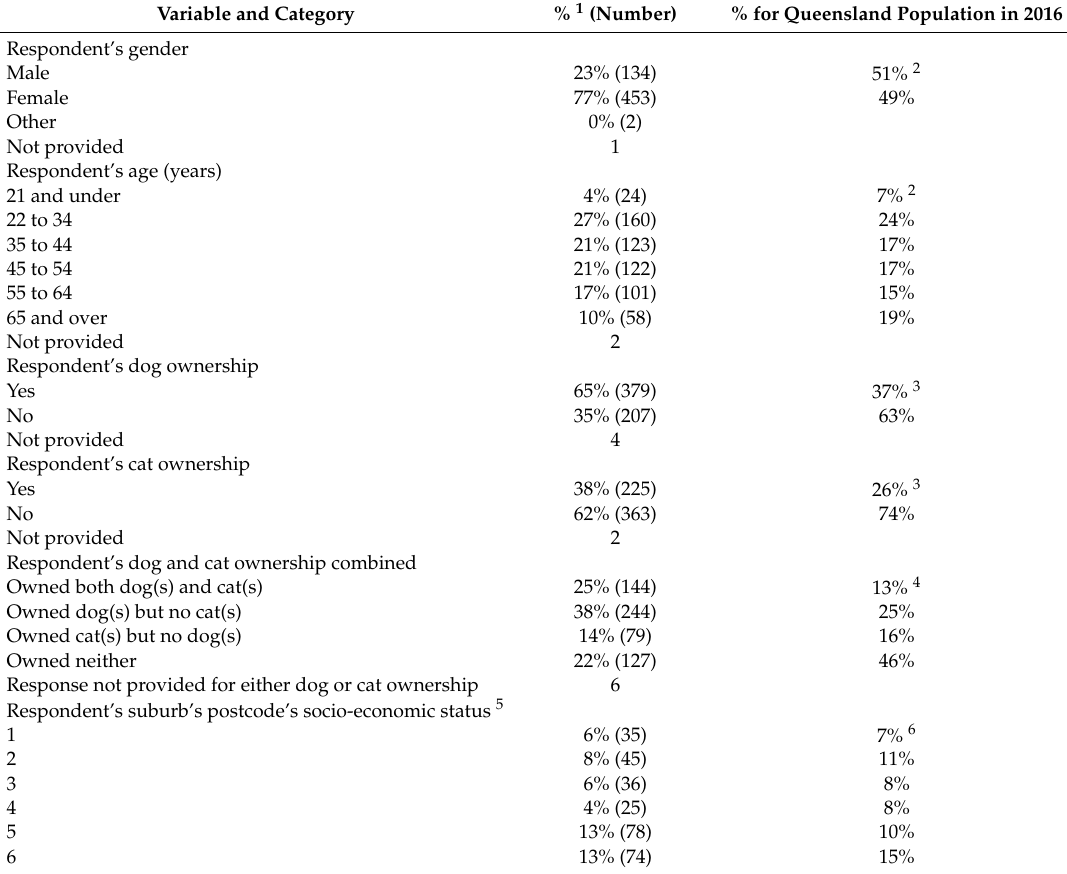
Table 1. Distributions of demographic variables for 590 study respondents used for analyses, and for Queensland’s population in